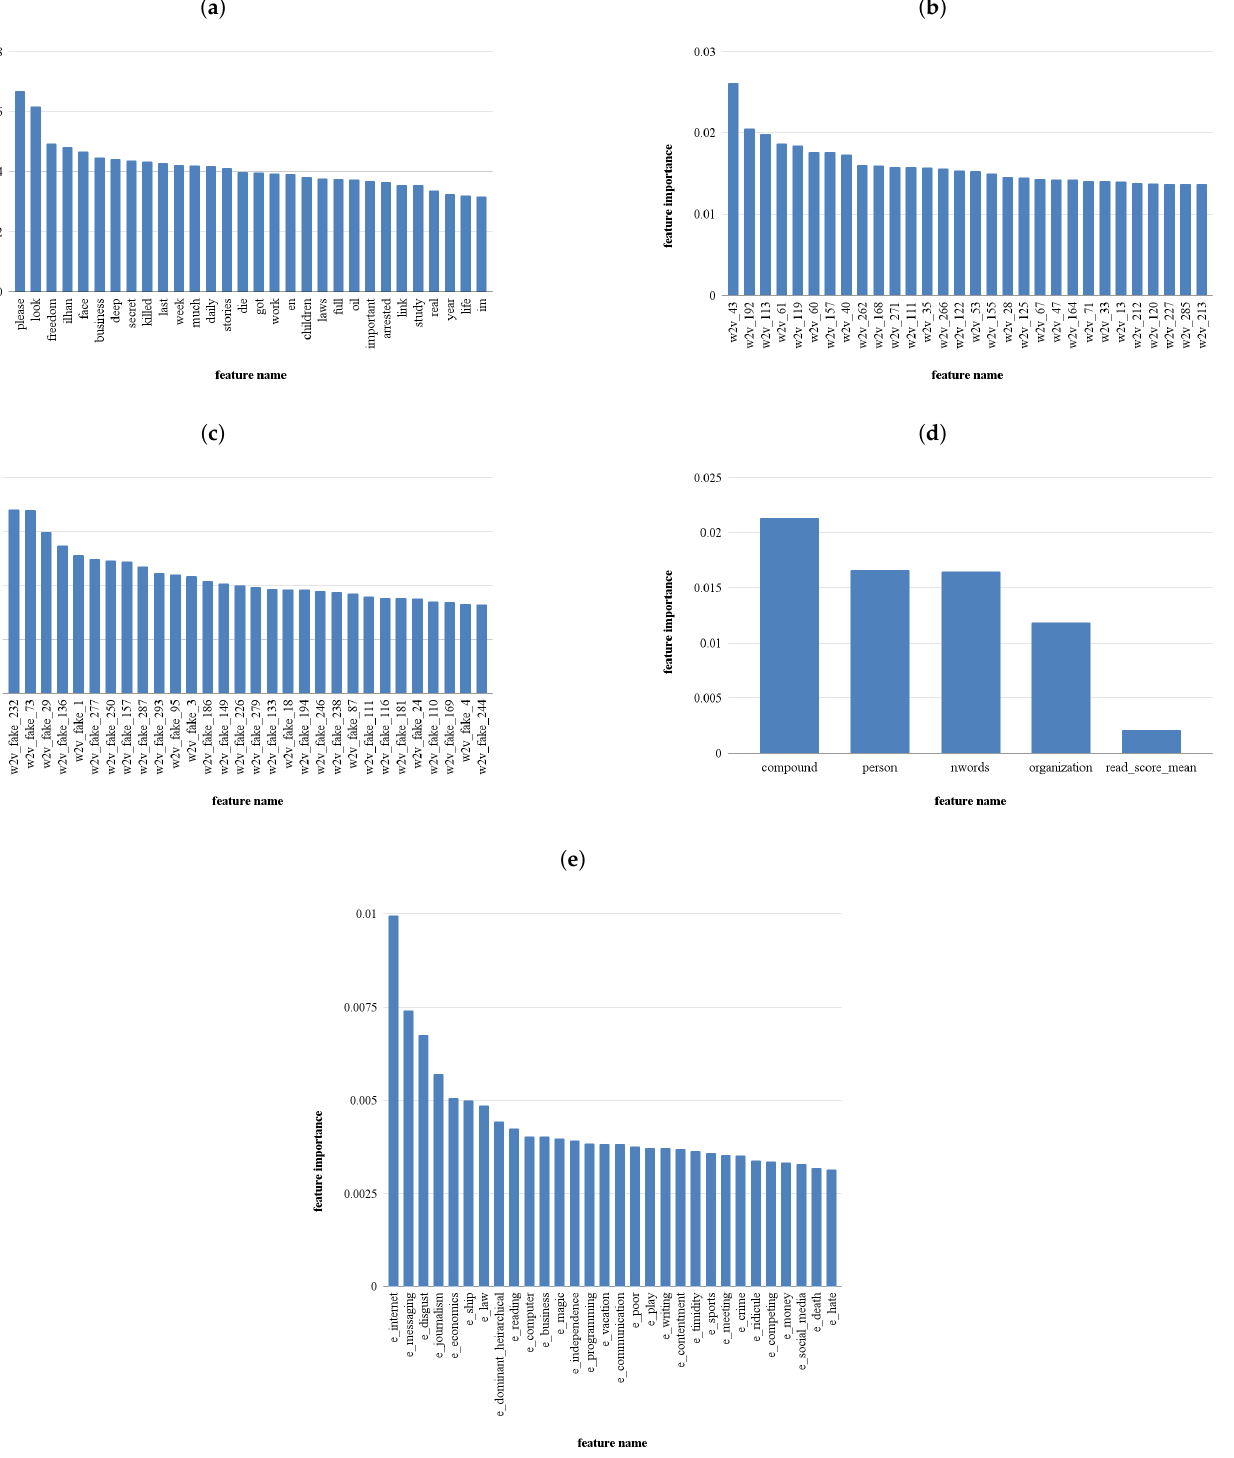
Figure A2. Importance of the 30 most relevant features from the different feature sets using a 60-day interval. In some scenarios, due to the pre-processing applied (removal of low variance and highly correlated features), the total number of features is inferior to 30. ( a ) Bag of Words; ( b ) Google Word2Vec; ( c ) Fake Word2Vec; ( d ) Context-free features; ( e ) Lexical Categories